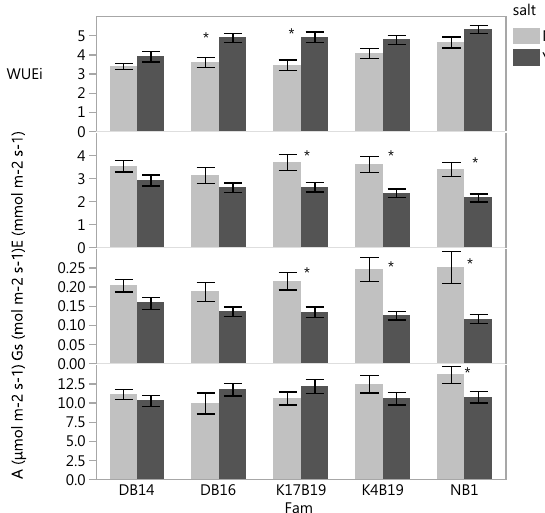
Figure 6. Effect of salt on net photosynthetic rate (A), stomatal conductance (G s ), transpiration (E), and intrinsic water use efficiency (WUE i ) of Senegalia senegal families under drought stress. Asterisk marks on bars mean significant effect of salt at p < 0.05.